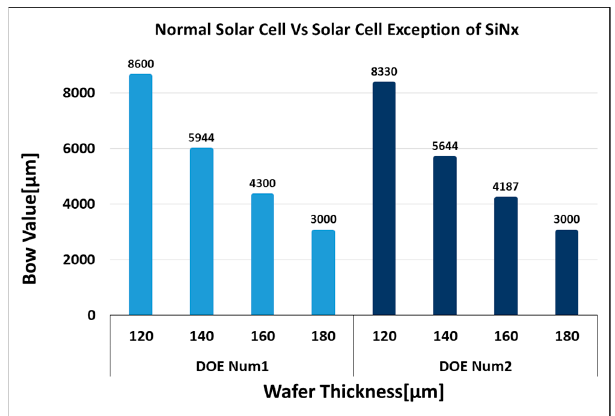
Figure 7. Bowing phenomenon due to thickness of wafer and presence or absence of ARC (anti-reflection coating) deposition on a c-Si wafer.